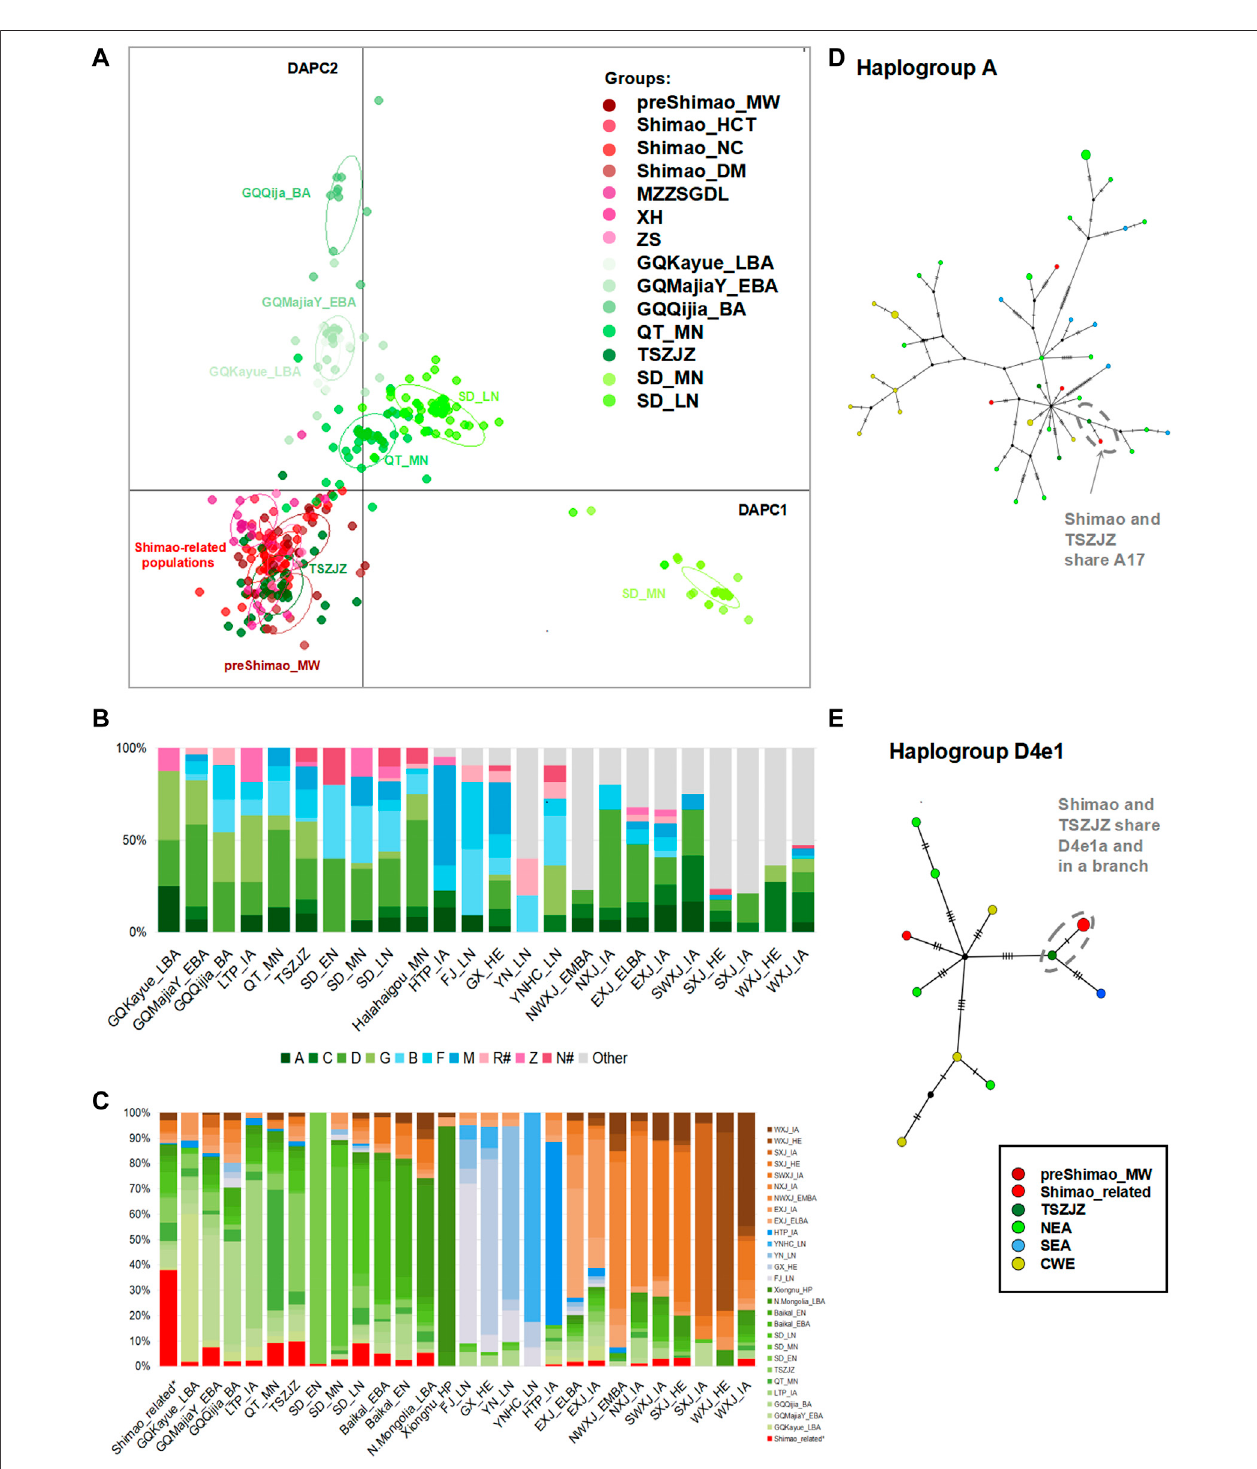
FIGURE 3 | The genetic analysis between Shimao-related populations and other ancient populations. (A) The discriminant analysis of principal components (DAPC) of ancient populations in YR. The red points represent the Shimao-related populations. The dark green points represent the TSZJZ individuals, and the other green points represent the individuals in YR. (B) Haplogroup frequency of ancient populations. The haplogroups with green are those common in NEAs, and those with bluearecommoninSEAs.ThehaplogroupsabsentfromShimao-relatedpopulationsaregroupedin “ Other. ” ThehaplogroupsR # andN # representthehaplotypes found in East Eurasians (such as haplotype R+16189, sub-haplogroups R11 and N9, which were also observed in the Shimao-related populations). The other sub- haplogroupsRandNfoundinWestEurasianswereassignedto “ Other. ” (C) Haplogroupsharinganalysis.Thedifferentcolorscorrespondto F ST heatmapandnetworks.